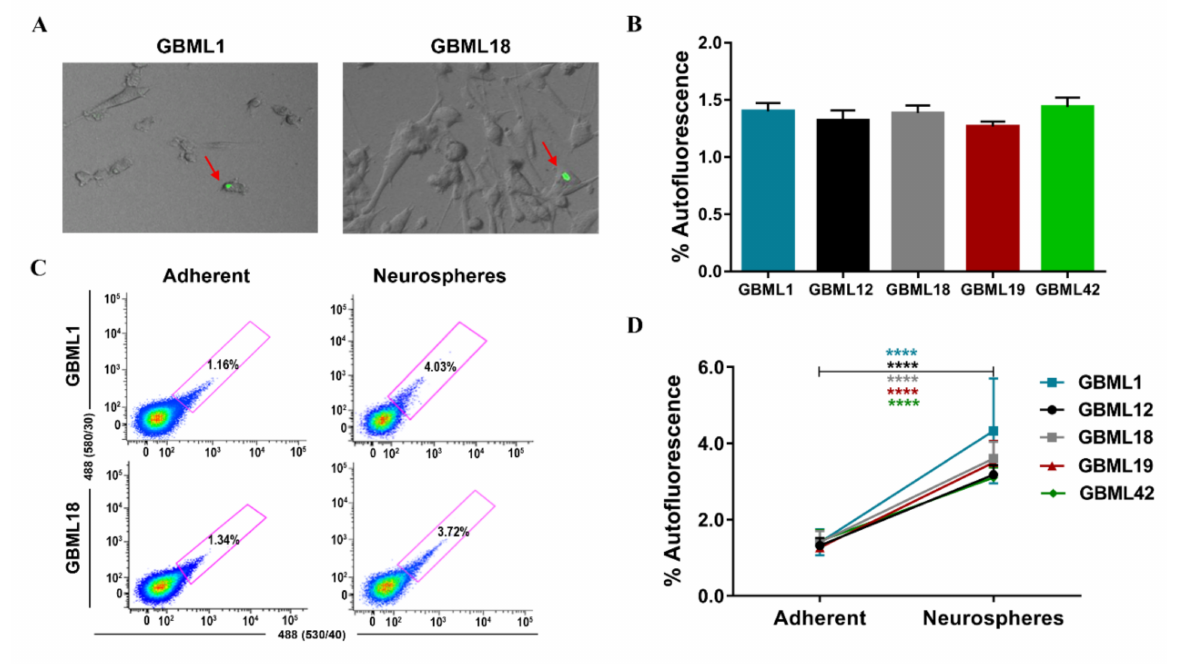
Figure 1. Primary GBM cultures present autofluorescent cells in adherent and neurosphere conditions. ( A ) Representative images of autofluorescent (Fluo + ) cells (arrows) in human primary GBM cultures, GBML1 and GBML18, grown in adherent conditions. ( B ) Flow cytometry quantification of the percentage of Fluo + cells across five independent human primary GBM cultures propagated in adherent conditions. ( C ) Representative flow cytometry plots indicating the percentage of Fluo + cells in GBML1 and GBML18 human primary cultures, grown in adherent (left) and neurosphere (right) conditions. ( D ) Percentage of autofluorescence across five human primary GBM cultures grown as adherent cells or neurospheres ( n ≥ 3). Data from ( B , D ) panels are represented as the mean ± SD of at least three independent experiments (**** p ≤ 0.0001); panels in ( C ) are representative plots of at least three independent